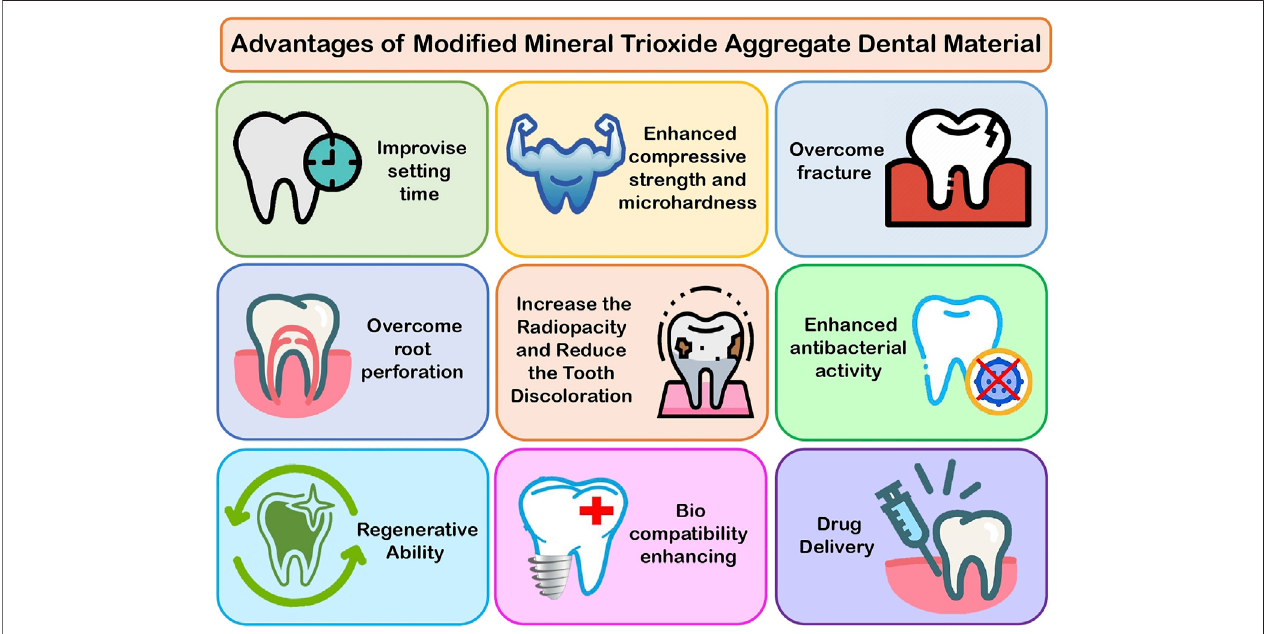
FIGURE 4 | Advantages of modi fi ed